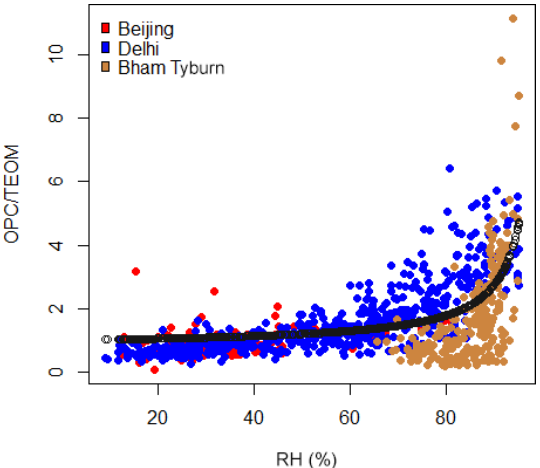
Figure 8. Humidogram using OPC-N2 data where there was dry reference mass (TEOM), coloured by location. The resultant κ fit (black) was generated using data from all three sites.